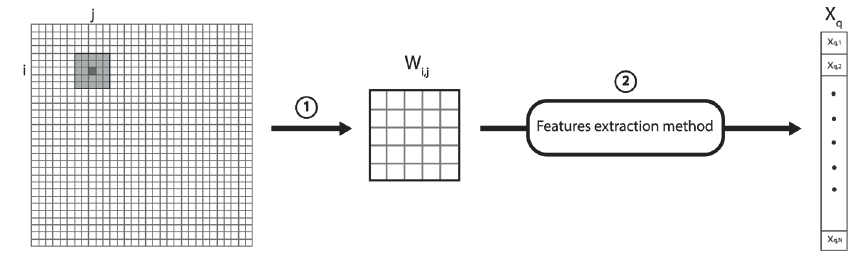
Fig. 1. Features extraction principle: (1) Analysis window, (2) Textural feature